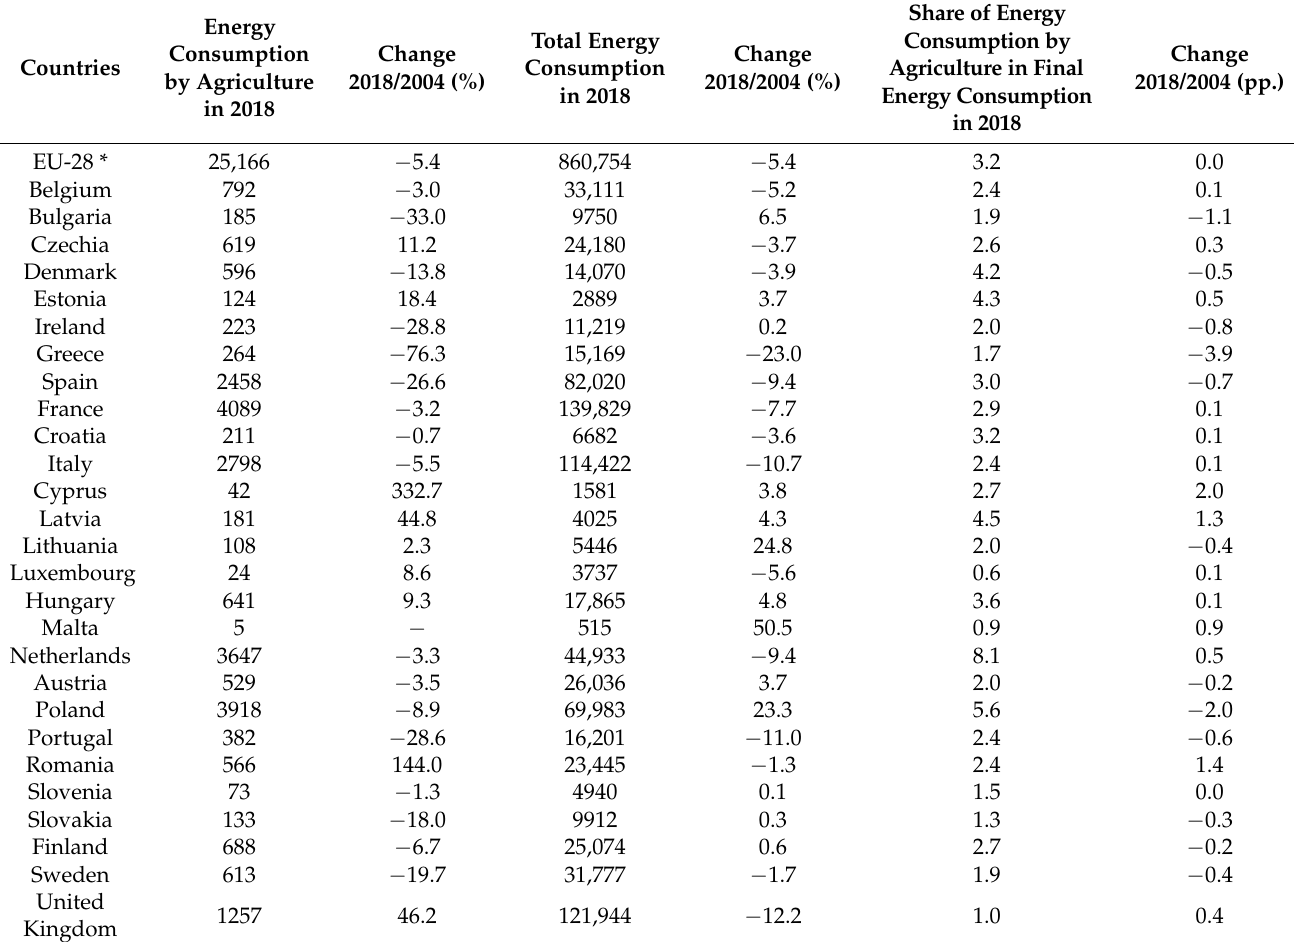
Table 1. Share of energy consumption by agriculture in final energy